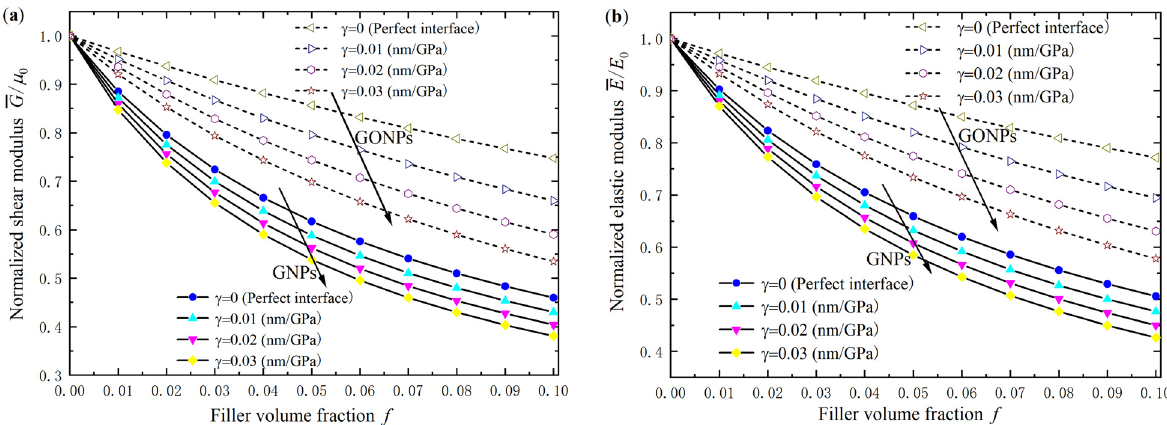
Figure 4: The relationship between the normalized shear modulus ( a ) and elastic modulus ( b ) of the nanoplate composite with the fi ller volume fractions and interface sliding